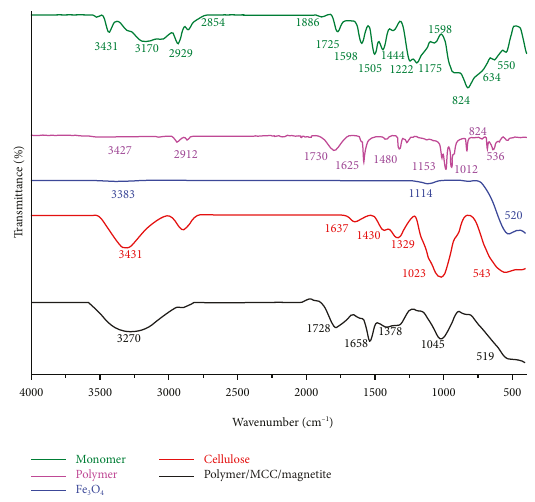
Figure 1: FTIR spectral comparison of poly(4,4 ′ -cyclohexylidene bisphenol oxalate)-MCC-Fe polymer and pure iron